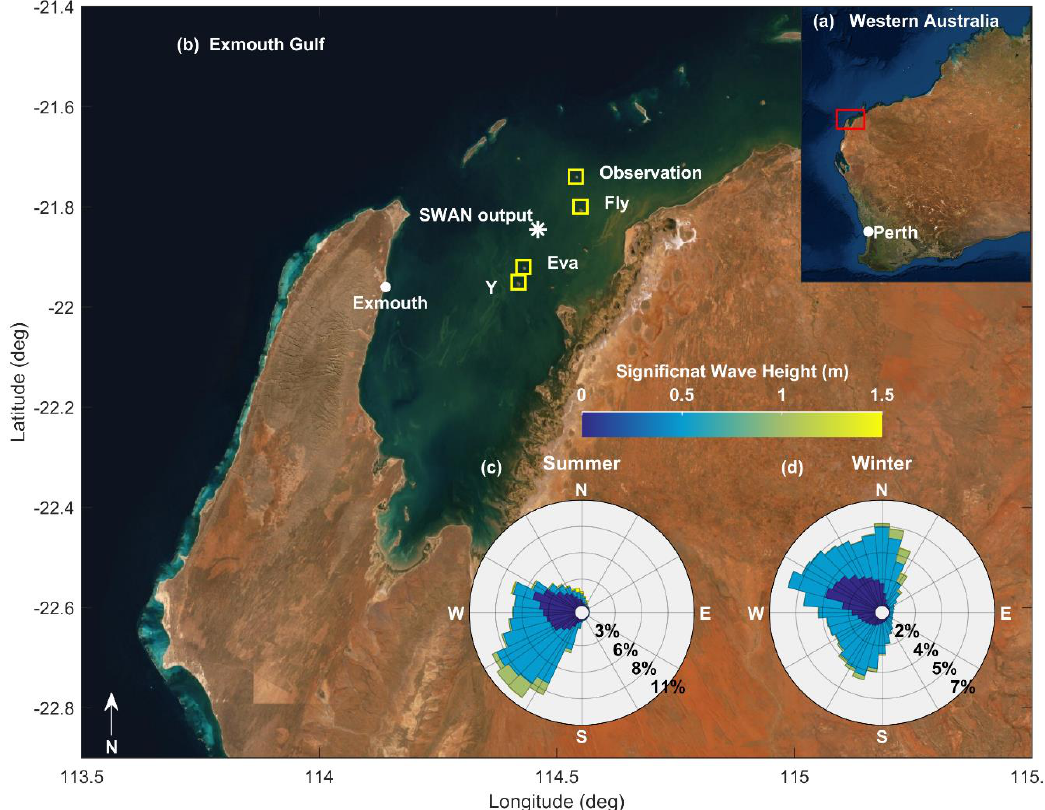
Figure 1. ( a ) Location of the study area, Exmouth Gulf, in the southwestern Pilbara (red box). ( b ) Satellite image of Exmouth Gulf including the location of the reef islands examined here (yellow squares), SWAN wave model output location (white asterisk), and location of the Exmouth tide gauge (white dot). ( c , d ) Characteristic wave climate for summer ( c ) and winter ( d ) in Exmouth Gulf. Percentages indicate frequency of occurrence for waves from a particular direction, and the colors indicate significant wave height. Wave parameters were extracted from a SWAN hindcast at the location marked in ( b ) (white asterisk). Basemap images in ( a , b ) are from ESRI